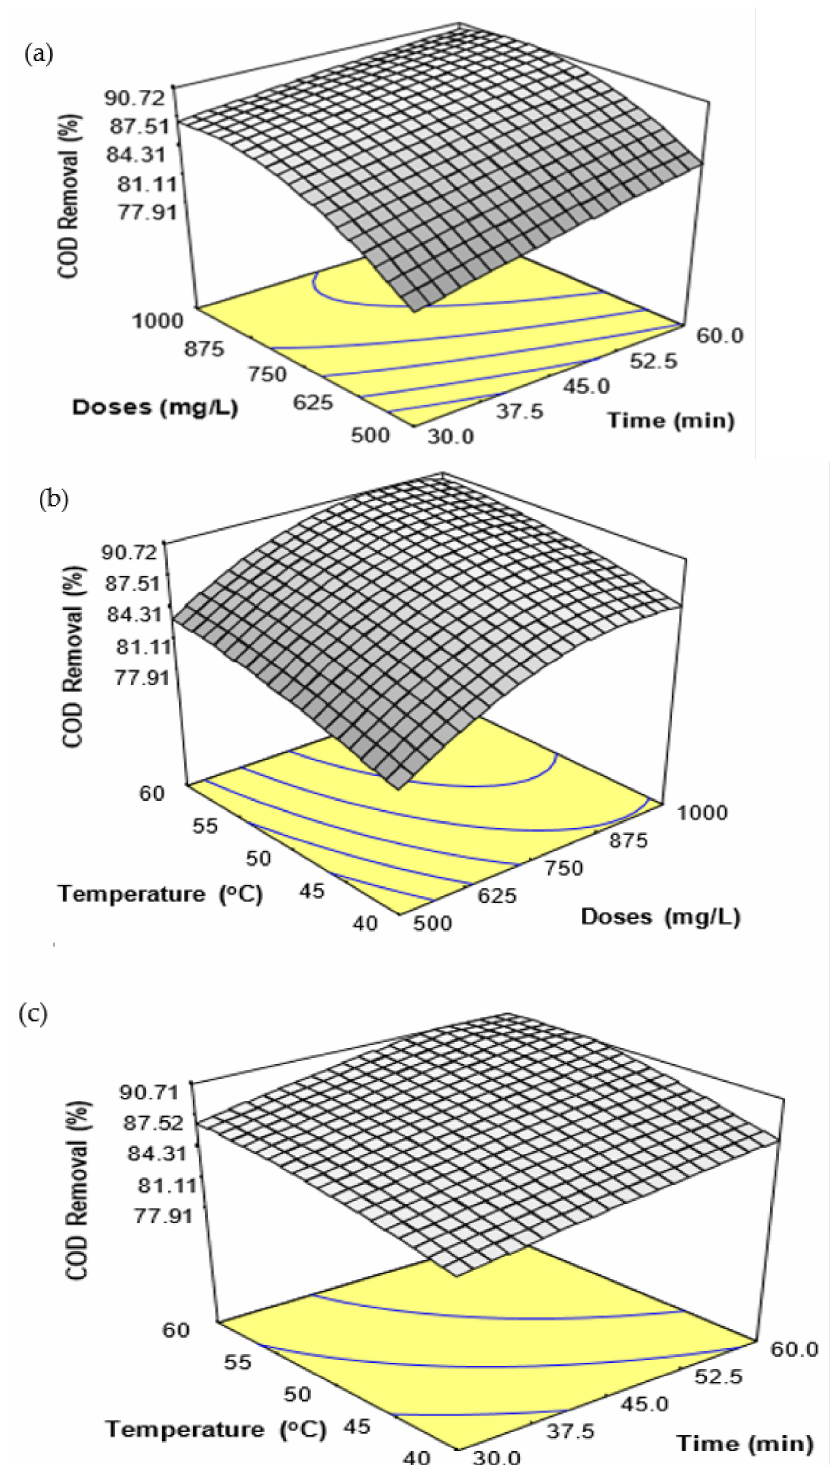
Figure 1. Response surface plots for the removal of COD from SRPE using FeSO 4 · 7H 2 O waste as a co- agulant. ( a ) Interaction effect between coagulation time and FeSO 4 · 7H 2 O waste doses, ( b ) Interaction effect between FeSO 4 · 7H 2 O waste doses and temperature, and ( c ) Interaction between coagulation time and